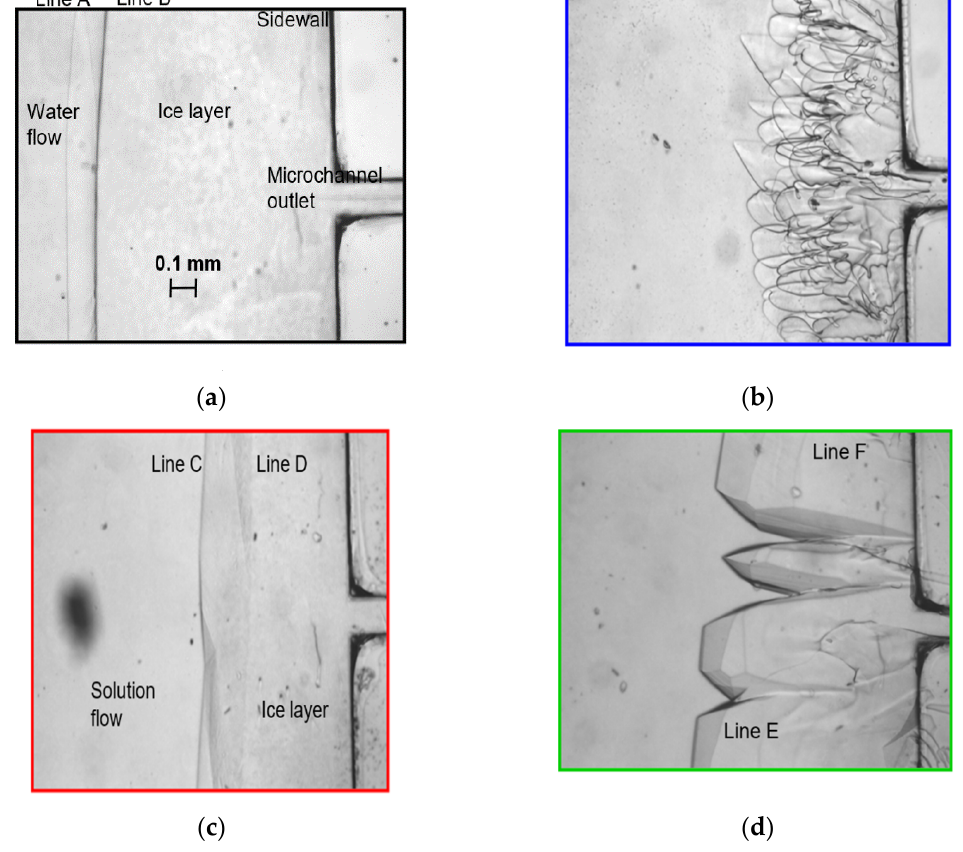
Figure 4. Typical images of ice/liquid flow interfaces in ice-layer growth stages: ( a ) DI water flow, ( b ) salt-solution flow, ( c ) HPLC6-solution flow, and ( d ) mixed-solution flow.